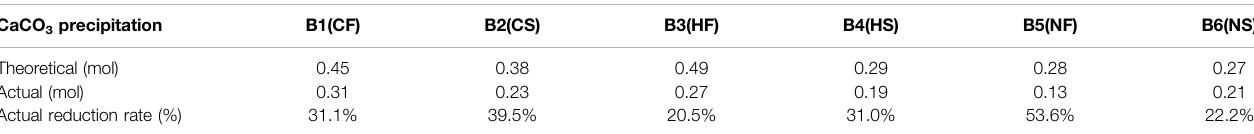
TABLE 3 | Relationships between theoretical mass value of calcium carbonate product and actual mass value of cementation solution experiment. CaCO 3